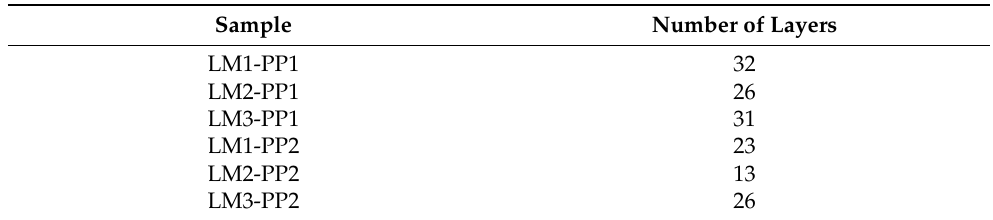
Table 2. Numbers of layers in turbostratic carbon